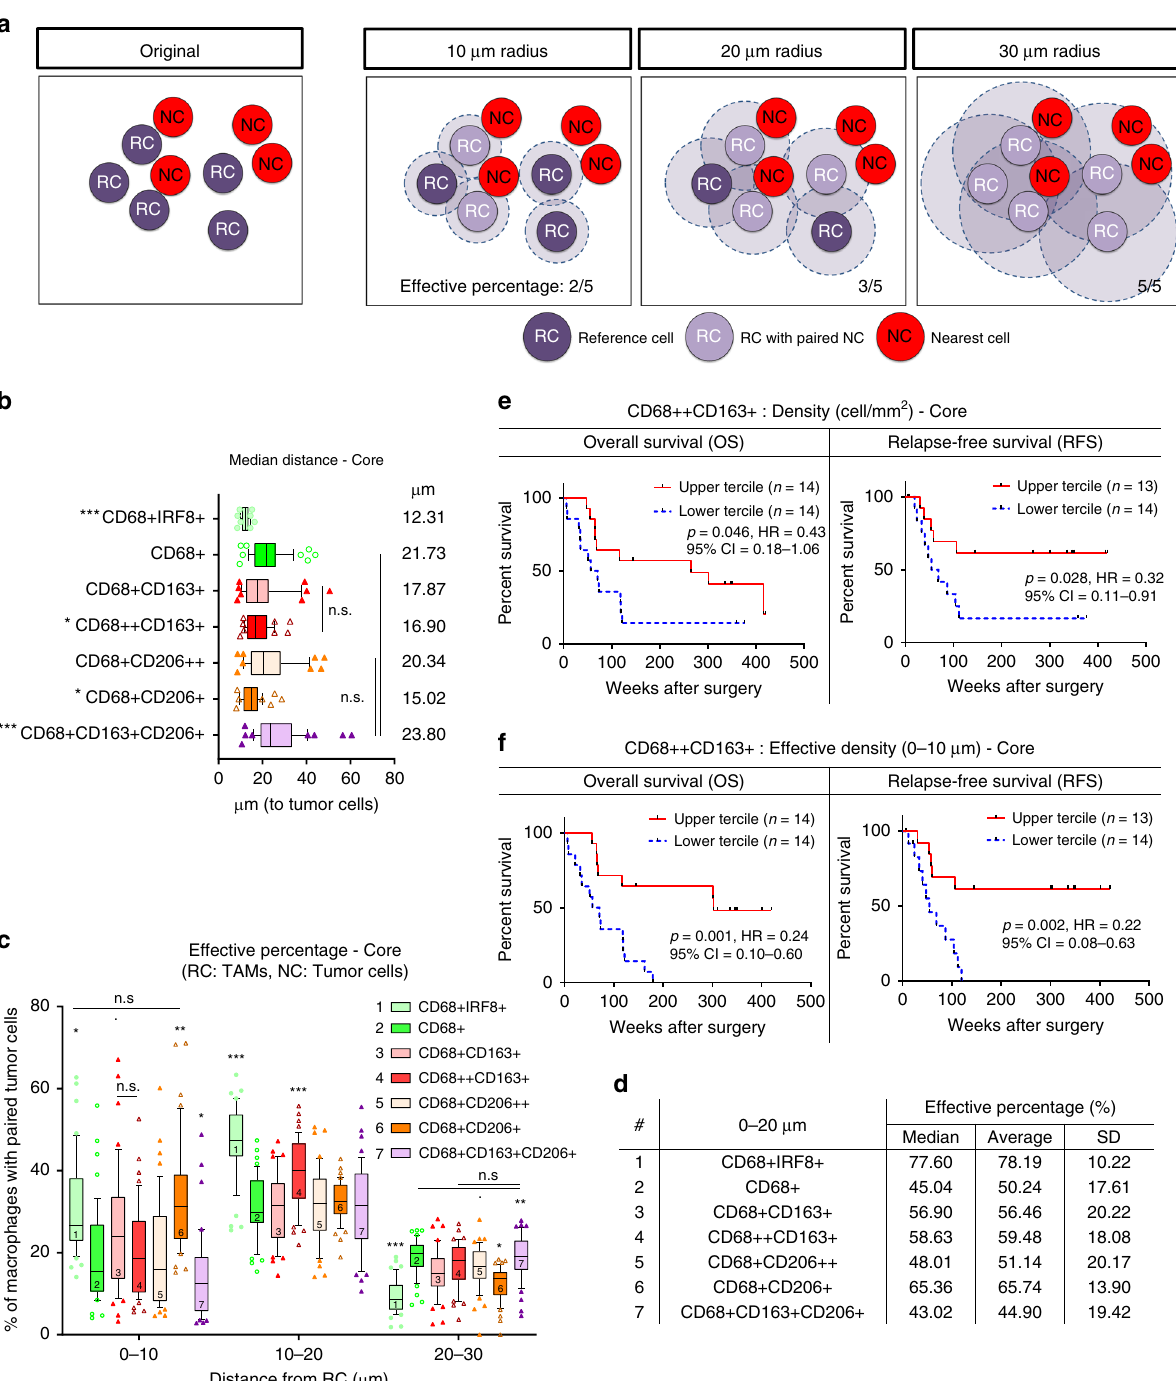
Fig. 3 TAM composition is associated with their proximity to tumor cells. a Schematic illustration of the distance analysis involving reference cell (RC) and nearest cell (NC). Each RC was paired with a neighboring NC in 10 µ m increments from its nucleus. Effective percentage represents the proportion of RC that had a paired NC in a given distance. b Median distance of TAM populations (RC) to tumor cell (NC). Box and whiskers represent mean ± 10 – 90 percentile. Each dot represents one patient. Core: n = 46. * p < 0.05, ** p < 0.01, *** p < 0.001 and not signi fi cant (n.s.). Mann – Whitney U test comparing between TAM populations. Circle: M1-like macrophages. Triangle: M2-like macrophages. c , d Effective percentage of TAM populations in the core ( c ) within 10 µ m increments and ( d ) within 0 – 20 µ m. e , f Overall survival (OS) and relapse-free survival (RFS) classi fi ed by the ( e ) overall CD68 ++ CD163 + TAM density and the ( f ) effective density (0 – 10 µ m) in the tumor core. Effective density (0 – 10 µ m): the number of TAM that had a tumor cell within a 10 µ m radius. Upper tercile (density > 2/3 of the patients in the cohort; red line), Lower tercile (density ≤ 1/3 of patients in the cohort; blue dash line).